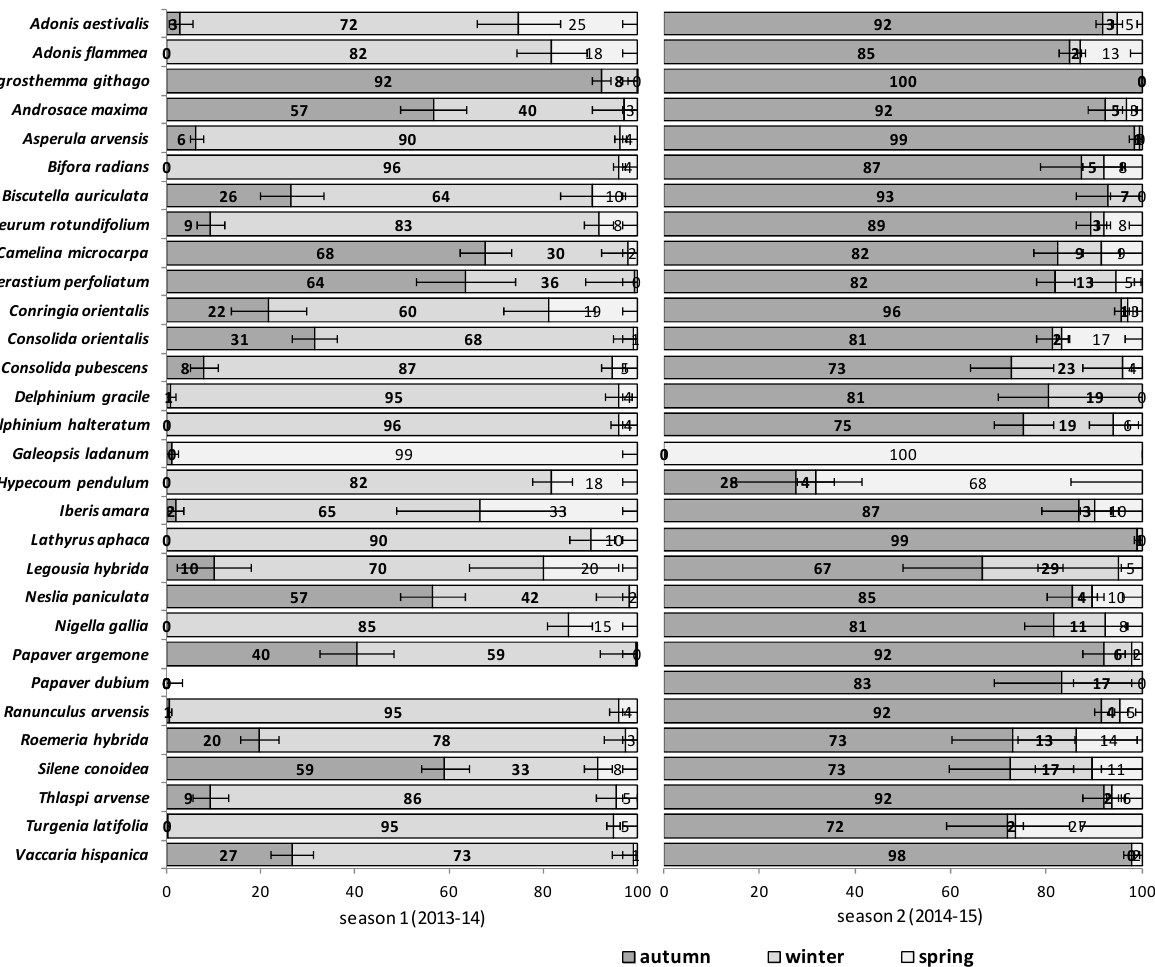
Figure 2. Relative Emergence patterns of 30 RAP in autumn (October through December), winter (January through February), and spring (March through April) during two consecutive seasons for seeds sown in 2013 (trial S2) in an arable field trial in Spain. Bars represent standard error. Two burial conditions are shown averaged: 1 cm burial depth without soil disturbance and 1–10 cm depth with annual autumnal soil disturbance. See Appendix A for relative emergence for each burial condition.